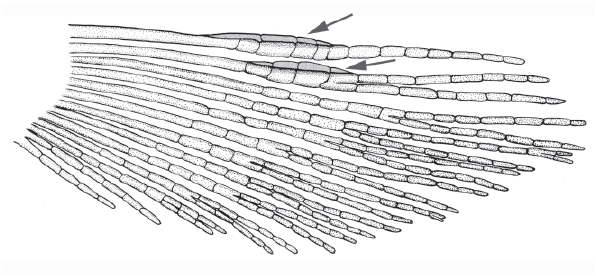
Fig. 5 . Lophiobrycon weitzmani , paratype, alizarin stained pectoral fin of adult male, ventral view, anteriormost fin ray at top, medial fin ray at bottom. Arrow indicates modified por- tions of the lepidotrichia supporting the diagnostic globular expansion, formed by the lepidotrichia and hypertrophied soft tissue (not represented in the illustration), in the middle portions of the unbranched (above) and first branched (be- low) pectoral-fin rays. LIRP 4338, 24.7 mm SL, same locality data as in Figs. 1 and